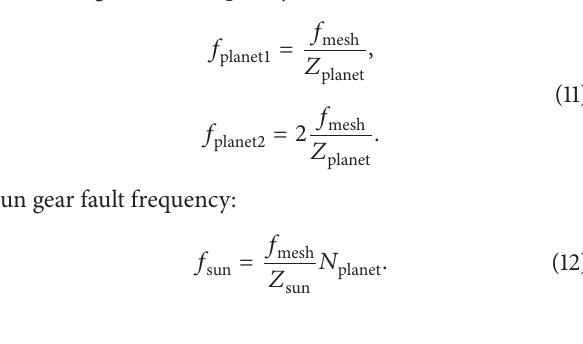
Figure 20: Gaussian signal added impulsive noise.